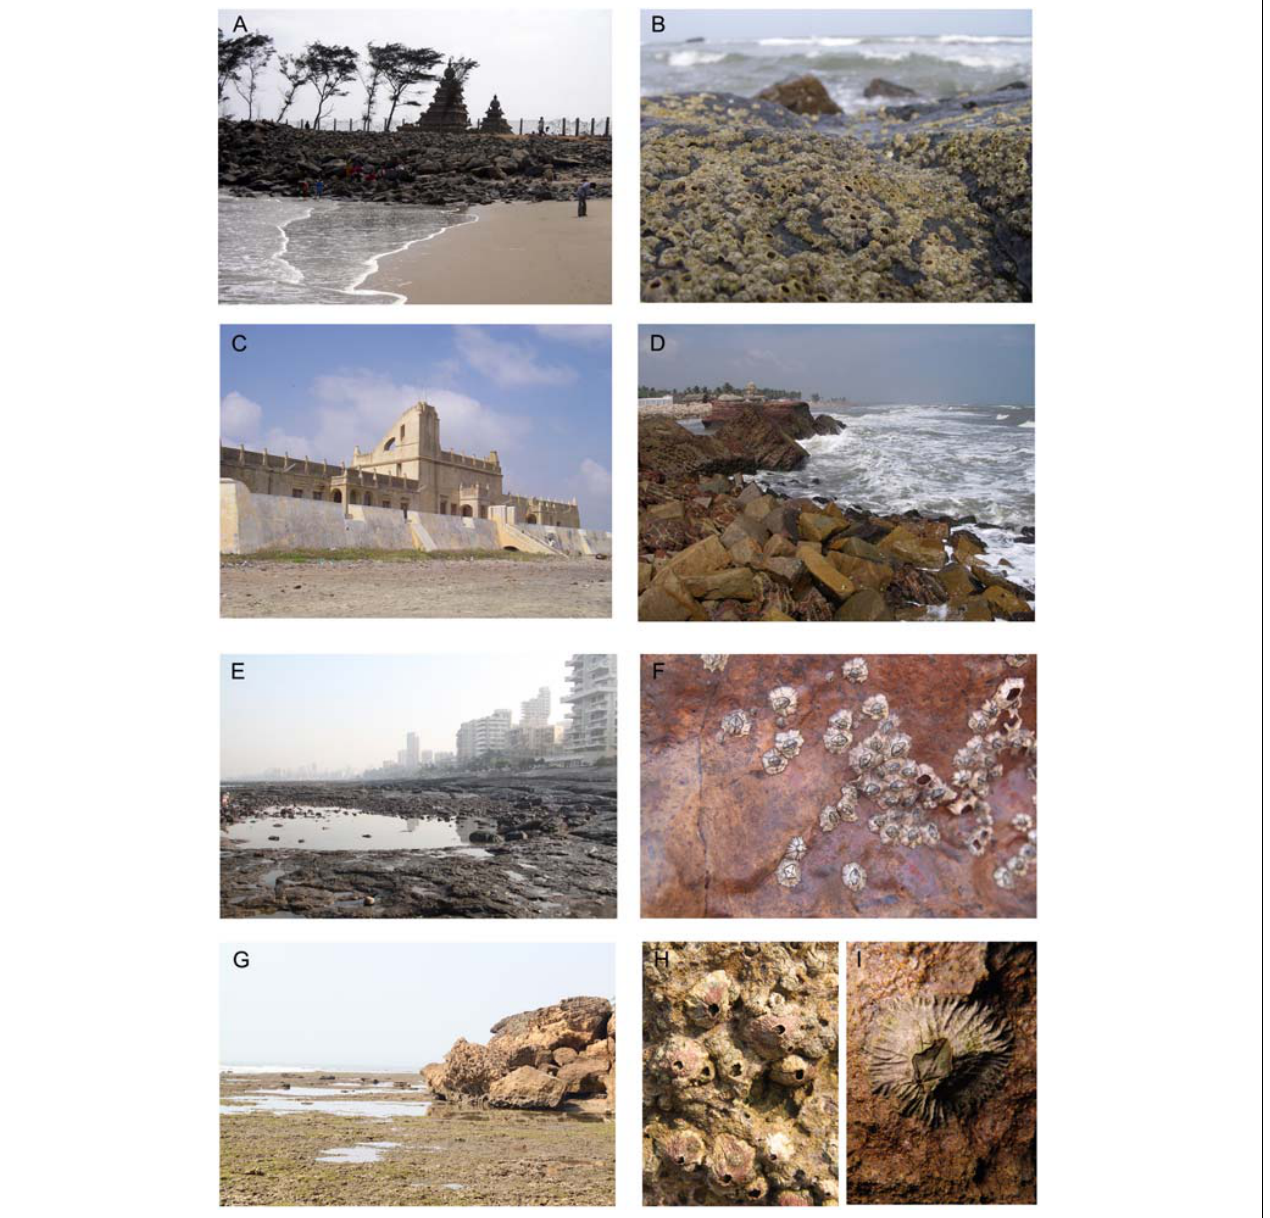
FIGURE 3 | Indian coastlines and barnacles. (A) Mamahariprum, eastern coast of India. Most of the hard substrates are large boulders. (B) Chthamalus malayensis is the dominant intertidal species on eastern coast of India. (C) Tranquebar, the remnants of Danish fort on coastline. (D) Coastline of Tranquebar is composed of large brick walls deteriorated from the Danish fort and large boulders. (E) Mumbai, large extent of rocky shores just below the urbanized city. (F) Microeuraphia withersi on the Mumbai coastline. (G) Diu, Gujarat showing the sandstone rocky shores. (H) Tetraclita ehsani in northwest India. (I) Tetraclitella karandei at Diu,